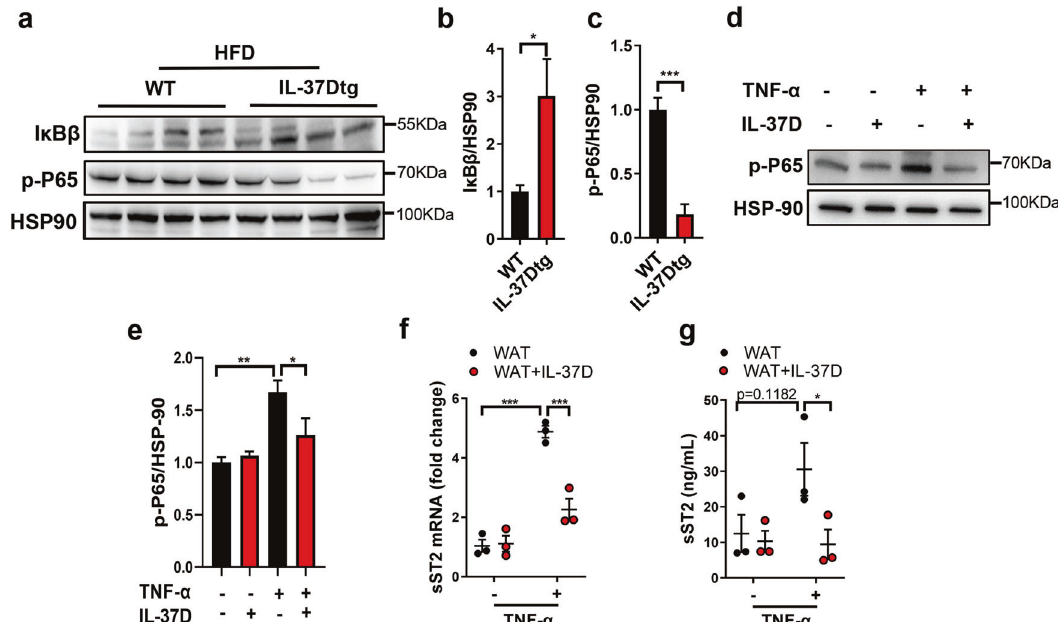
Fig. 6 Either endogenous or exogenous IL-37D blocks NF- κ B activation and sST2 production in WAT. IL-37Dtg and WT mice were fed on HFD for 23 weeks ( n = 4 per group). The protein levels of I κ B and p-P65 in inguinal WAT were detected by western blot ( a ) and the